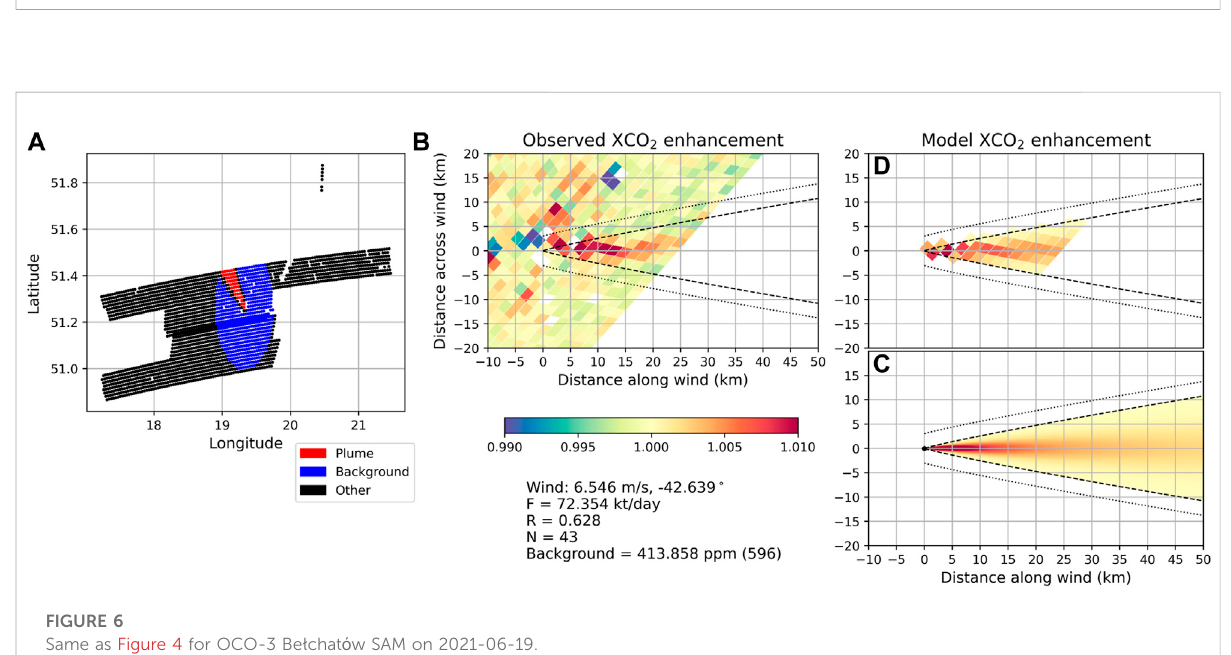
FIGURE 6 Same as Figure 4 for OCO-3 Be ł chat ό w SAM on 2021-06-19.